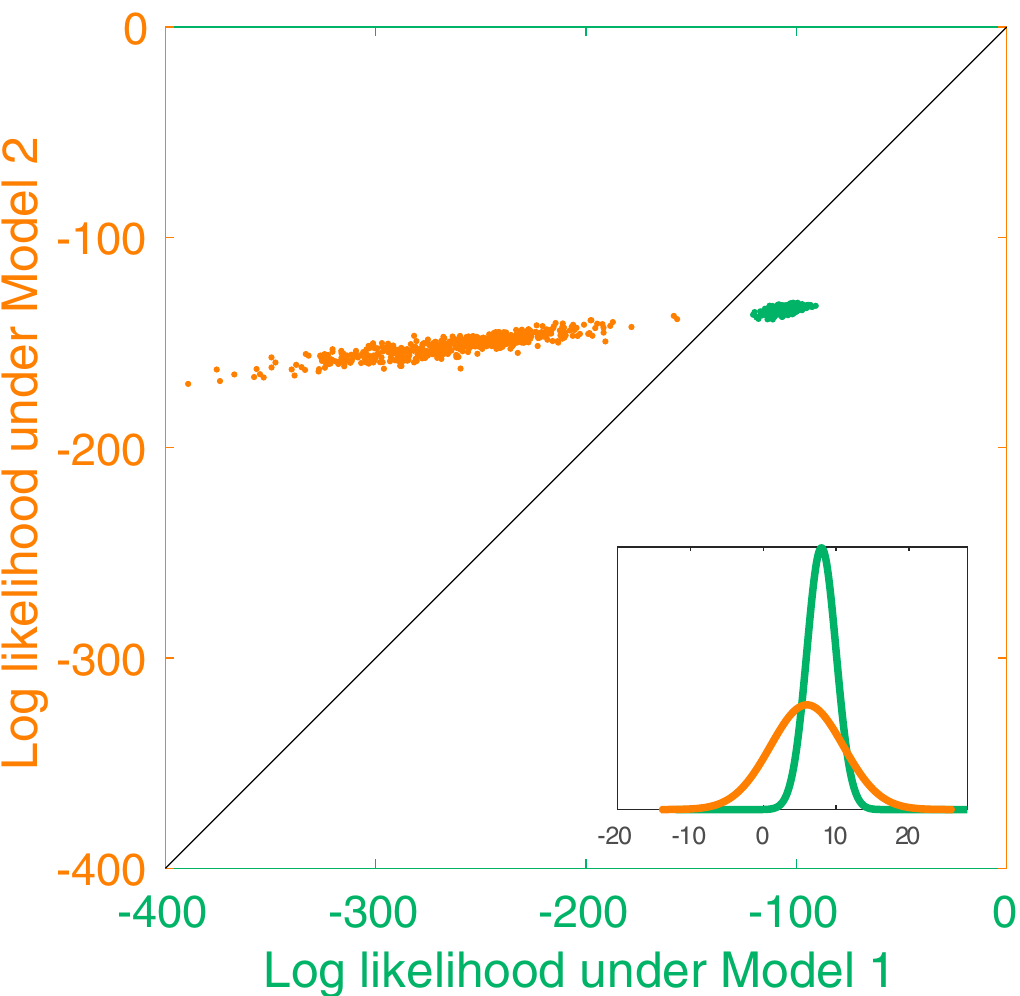
Fig 11. Illustration of model comparison. The inset shows two Gaussians as two ‘toy’ models. Each point in this plot shows the likelihood of 50 samples taken from one model and evaluated under each of the models. Samples taken from either model (Model 1, green Gaussian and green dots, or Model 2, orange Gaussian and orange dots) have similar distributions of likelihoods when evaluated under Model 2 (y-axis values overlap). The reverse is not the case: evaluating the likelihood of the same samples under Model 1 gives rise to quite distinct distributions of likelihoods (x-axis values are